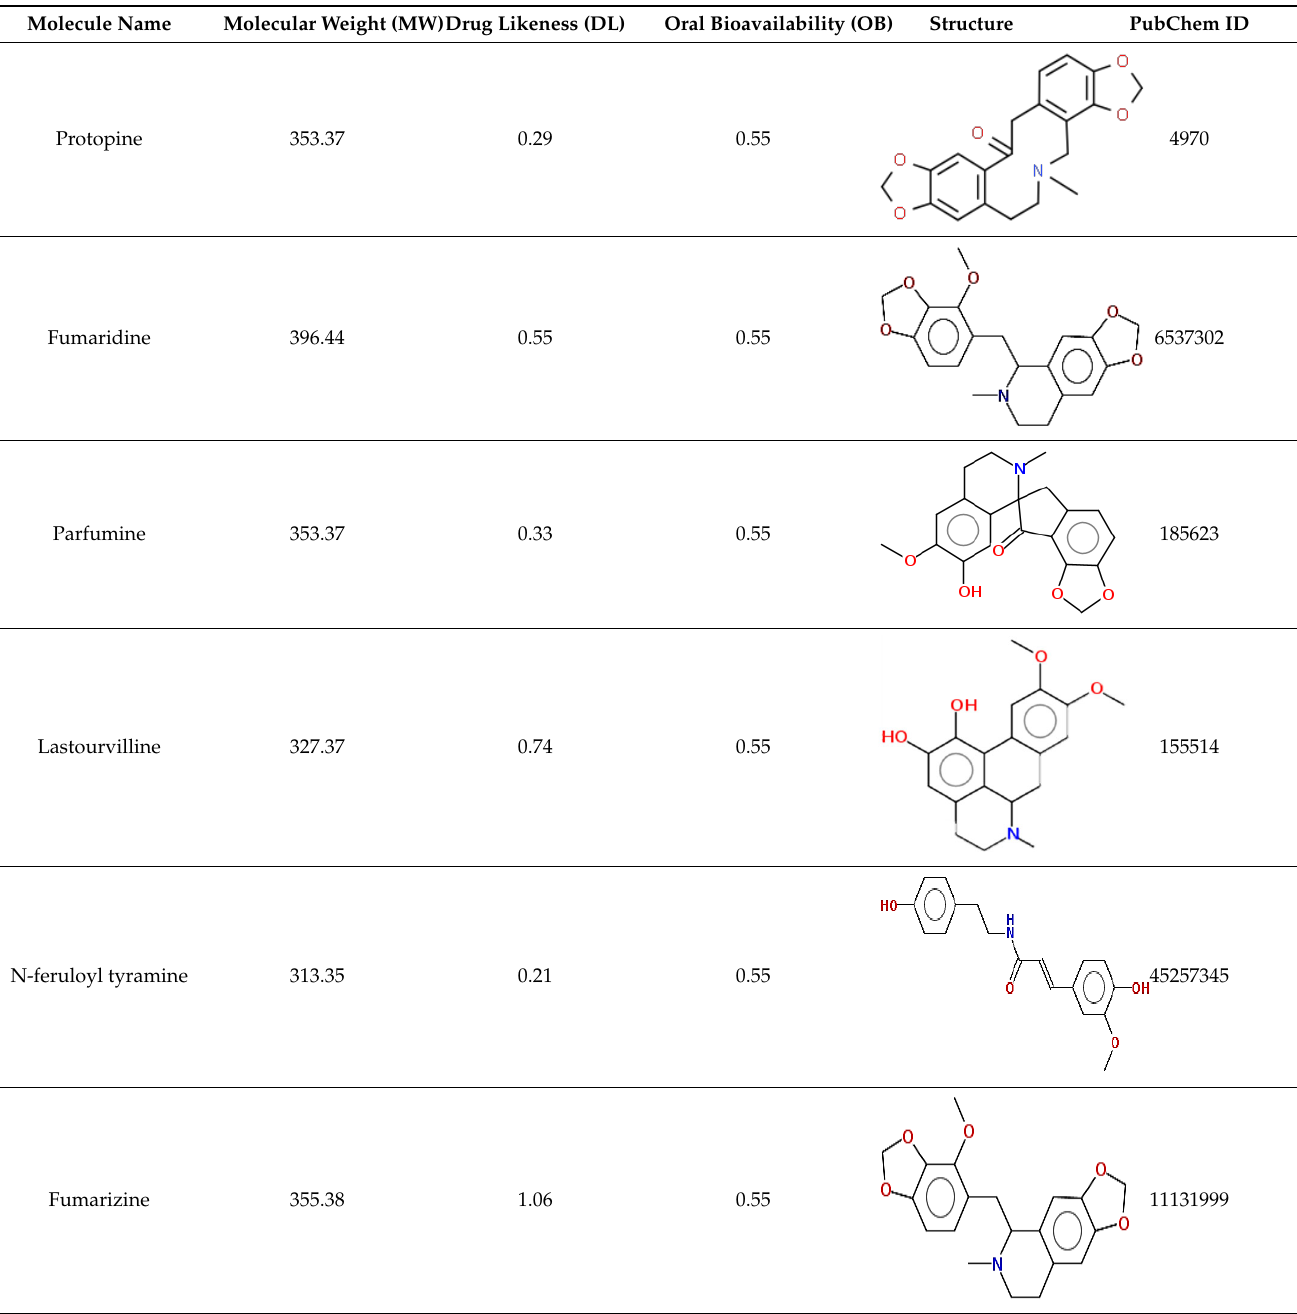
Table 1. Fifteen active compounds, their properties and structures.